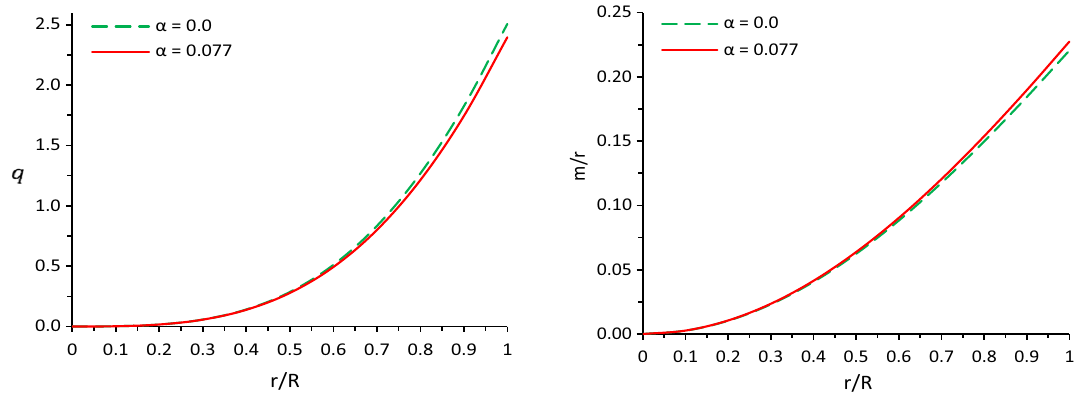
Fig. 14 The variation of electric charge ( q ) (left panel) and mass-radius ratio ( m / r ) (right panel) versus radial coordinate r / R for different values of α . For plotting this graph, we have used same numerical values of the constants as used in Fig. 12 Table 2 Numerical values of physical parameters central density ( ρ tot c ), surface density ( ρ tot s ), central pressure ( p tot c ), constant B and C for star PSR J1416-2230 with different values of α with β = 1 . 1 , γ = − 0 . 001, a = 0 . 003, and b = 0 . 0000053 Values ( α ) Predicted radius ( R ) (km) ρ tot c ( gm / cm 3 ) ρ tot s ( gm / cm 3 ) p tot c ( dyne / cm 2 ) Electric charge Q (in coulomb) B (km − 2 ) C